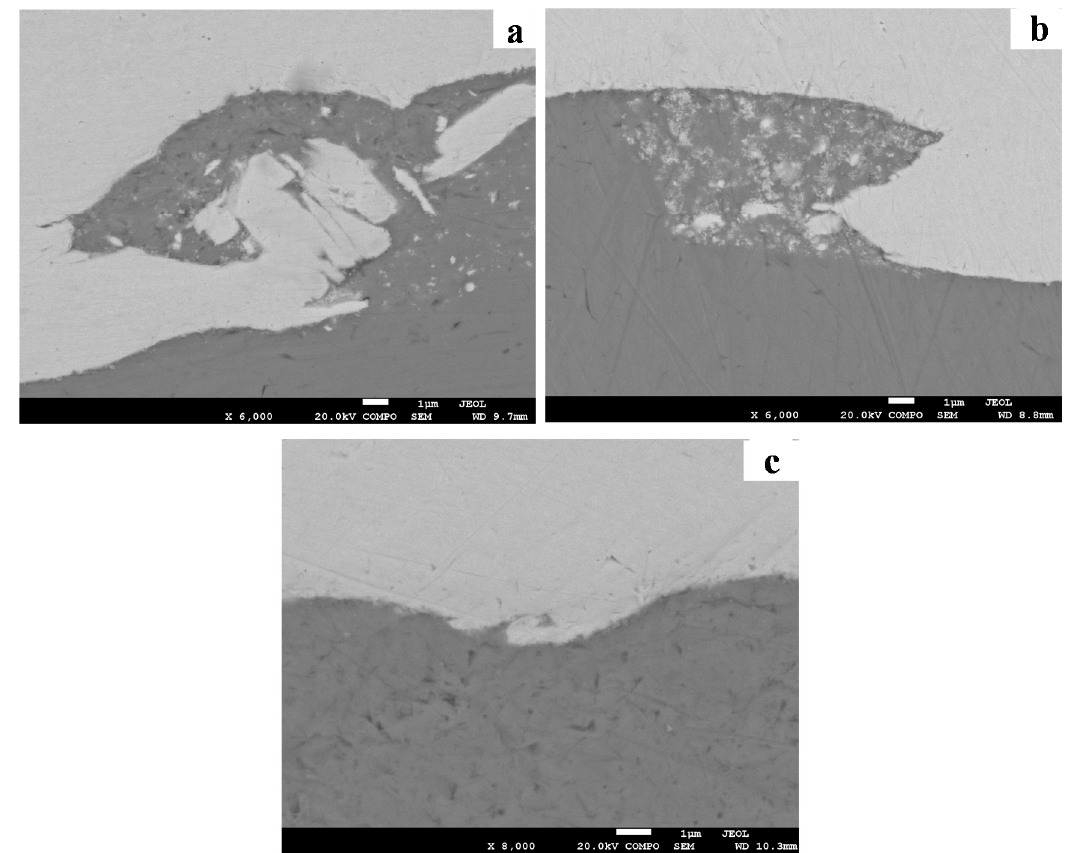
Figure 10. SEM images of the W–Cu interface: ( a ) T-3; ( b ) T-6; ( c ) T-8.